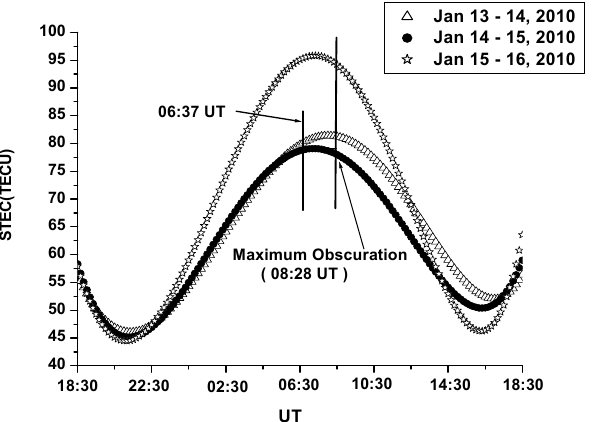
Fig. 11. The best-fit diurnal plots using a polynomial curve of degree 5 corresponding to the period 13–14 January through 15– 16 January 2010.